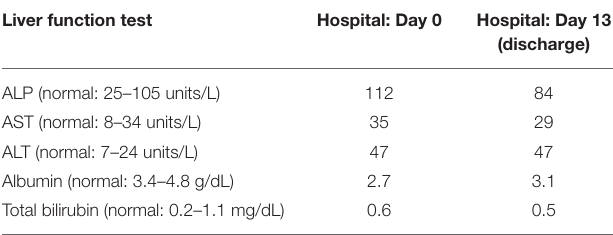
TABLE 1 | Liver biochemical profile of our patient before and after antimicrobial treatment. Liver function test Hospital: Day 0 Hospital: Day 13